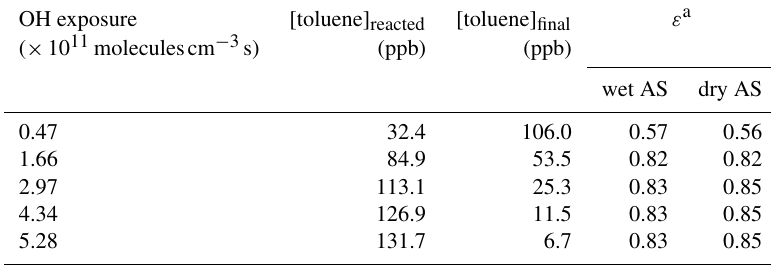
Table 1. Summary of the results for the initially dry and wet-AS-seed experiments. OH exposure [toluene] reacted [toluene] final ε